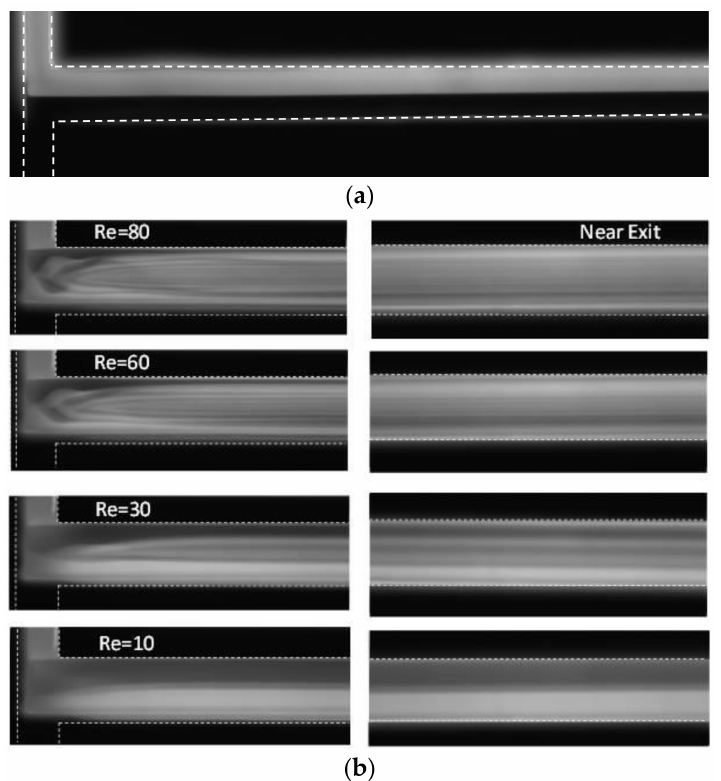
Figure 7. Planar mixing images obtained by experiment for ( a ) the simple T-mixer, Re = 80 and ( b ) the vortex micro T-mixer at different Reynolds numbers near the junction (left) and the exit of the mixing channel